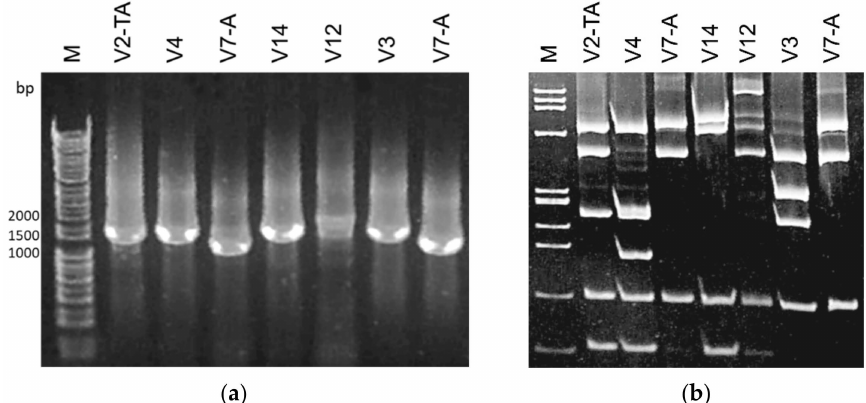
Figure 2. ( a ) Agarose gel (1%) showing representative amplicon sizes of the vmp1 gene obtained with the nested primer pair TYPH10F/R. In lanes V2-TA, V4, V14, and V3: amplicons of about 1450 bp; in lanes V7-A: amplicons of about 1200 bp; in lane V12: an amplicon of about 1700 bp. M: Ladder, 1 kb DNA; ( b ) Polyacrylamide gel (6.7%) showing representative Rsa I RFLP patterns of digested vmp1 gene amplicons obtained with the primer pair TYPH10F/R. M: Ladder, Φ X174 Hae III digested with fragment sizes in base pairs from top to bottom of 1353, 1078, 872, 603, 310, 281, 271, 234, 194, 118, and 72.